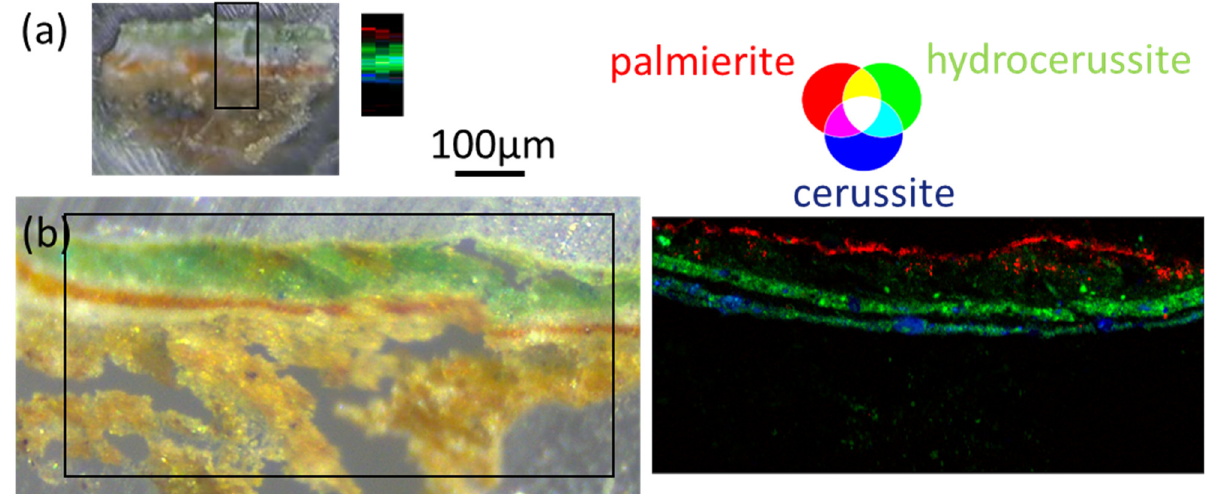
Figure 2. µXRPD maps of two sections of a fragment from a Bamiyan wall painting, acquired ( a ) in 2006 at the ESRF at the former ID18F beamline (map size: 150 × 60 µm 2 , pixel size: 1 × 20 µm 2 ), and ( b ) in 2021 at beamline ID13 (map size: 800 × 370 µm 2 , pixel size: 1 × 1 µm 2 ). The two acquisitions are displayed with the same scale (see text for technical details).